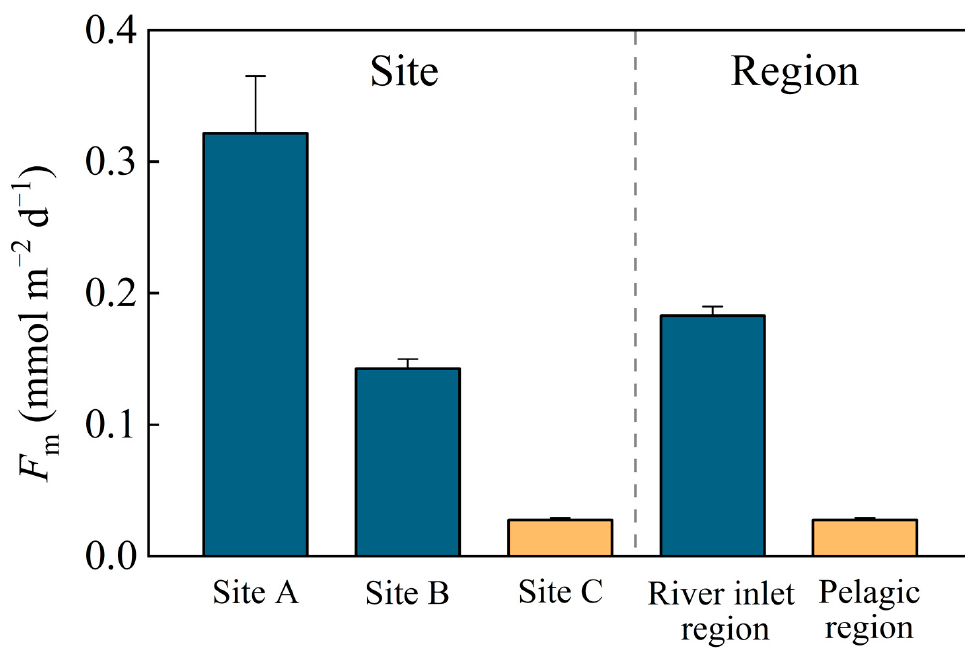
Figure 4. Spatial variations of CH 4 diffusion flux in different sites and different regions of Lake